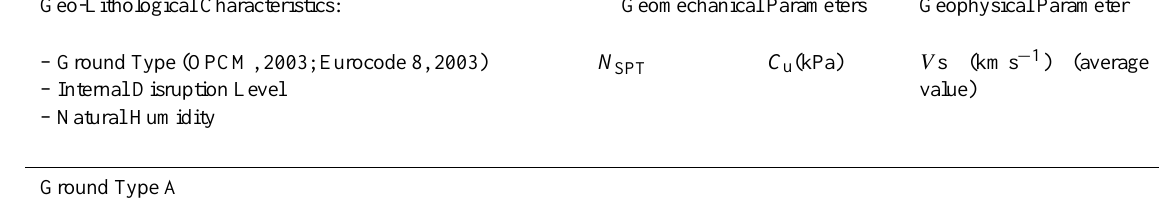
Table 3. Rock and soil classification based on geo-lithological, geomechanical and geophysical features (modified after Rapolla et al., 2010). Geo-Lithological